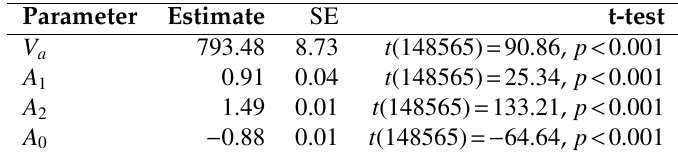
Non-linear regression coefficients and their significance tests for the inverse-linear logistic function fit to superpositioned microsaccades and saccades .